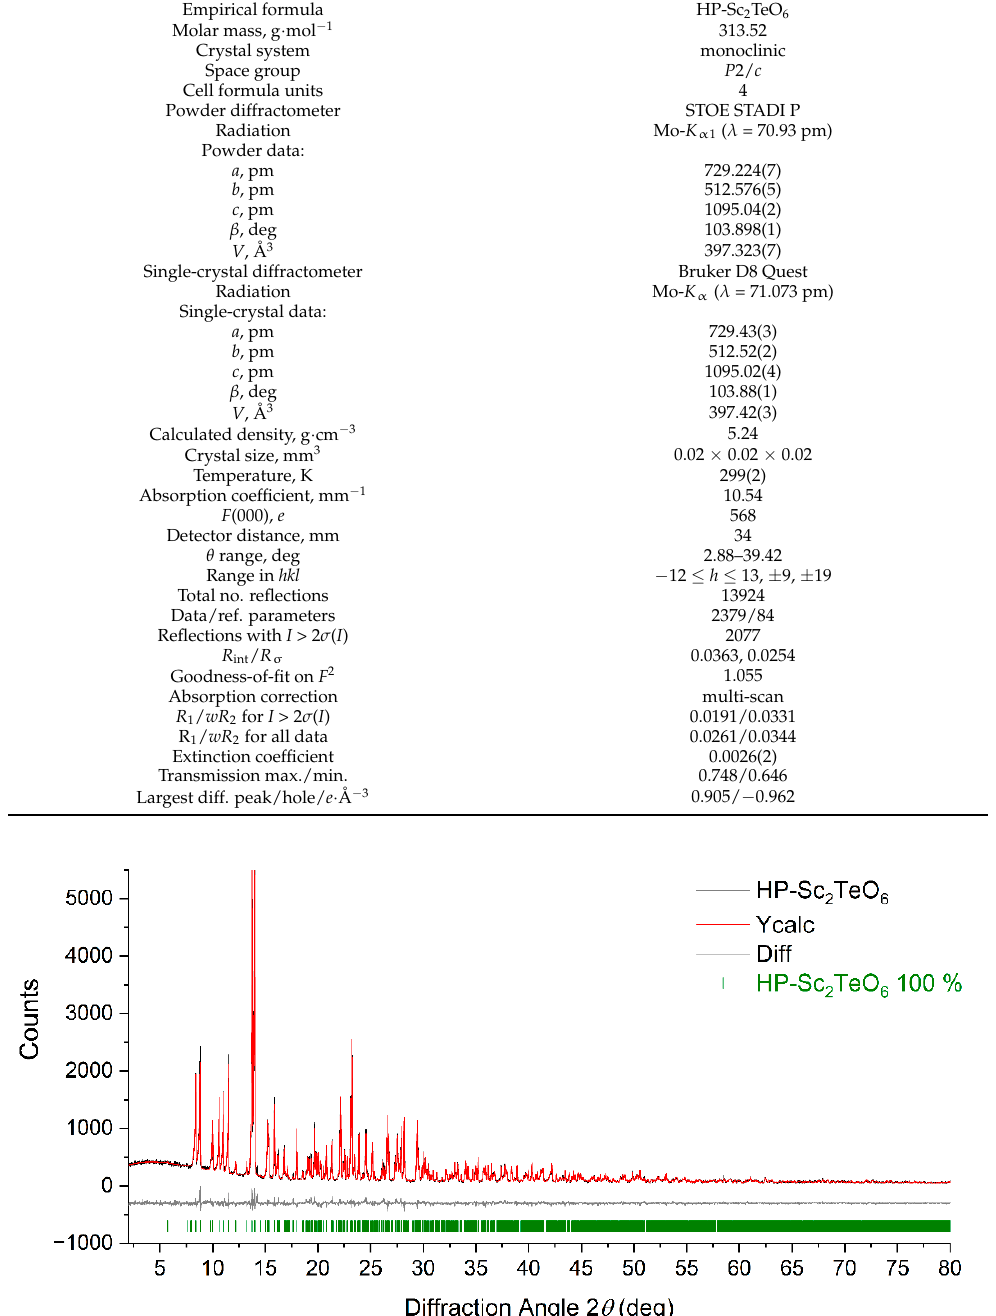
Table 1. Crystal data, data collection and structure refinement results for HP-Sc 2 TeO 6 .